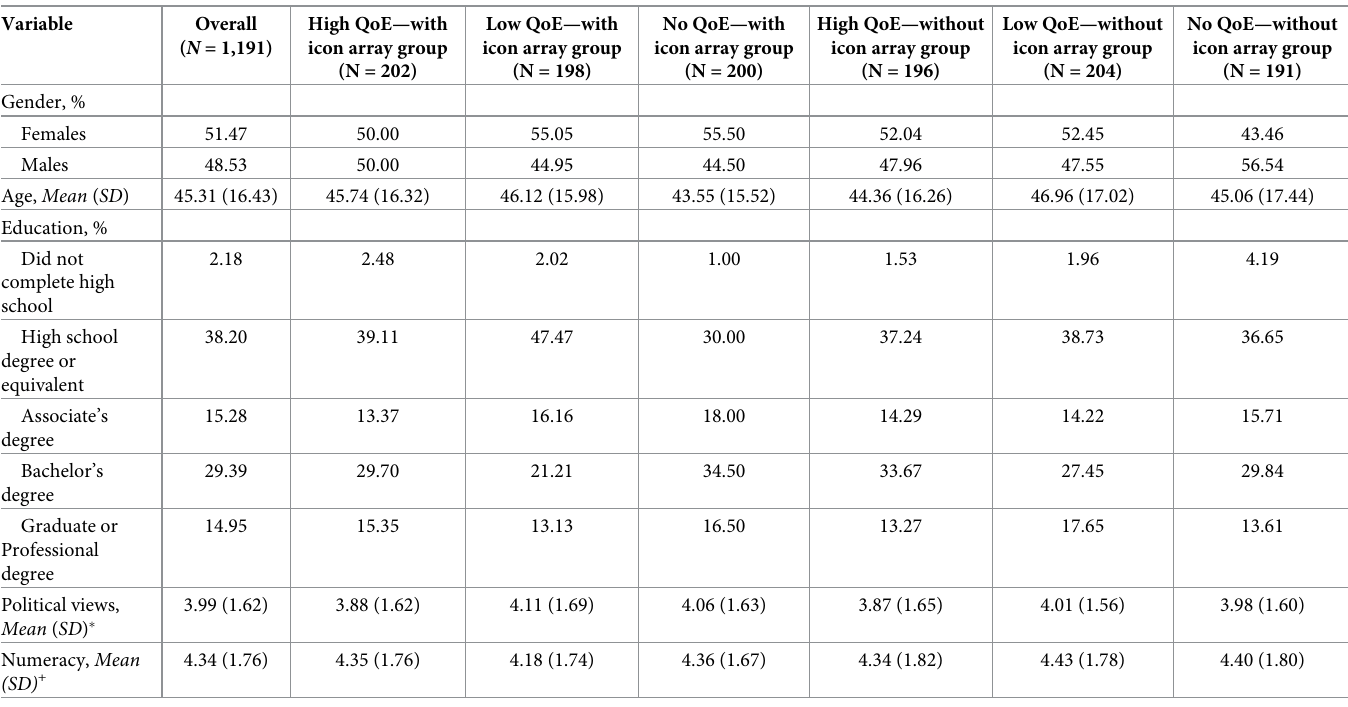
Table 6. Demographic details of participants in Experiment 2.